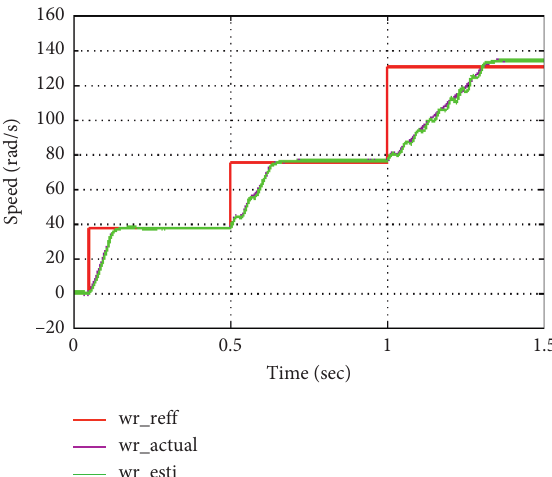
Figure 13: 75% increase of all parameters from their nominal value for different rotor speeds.